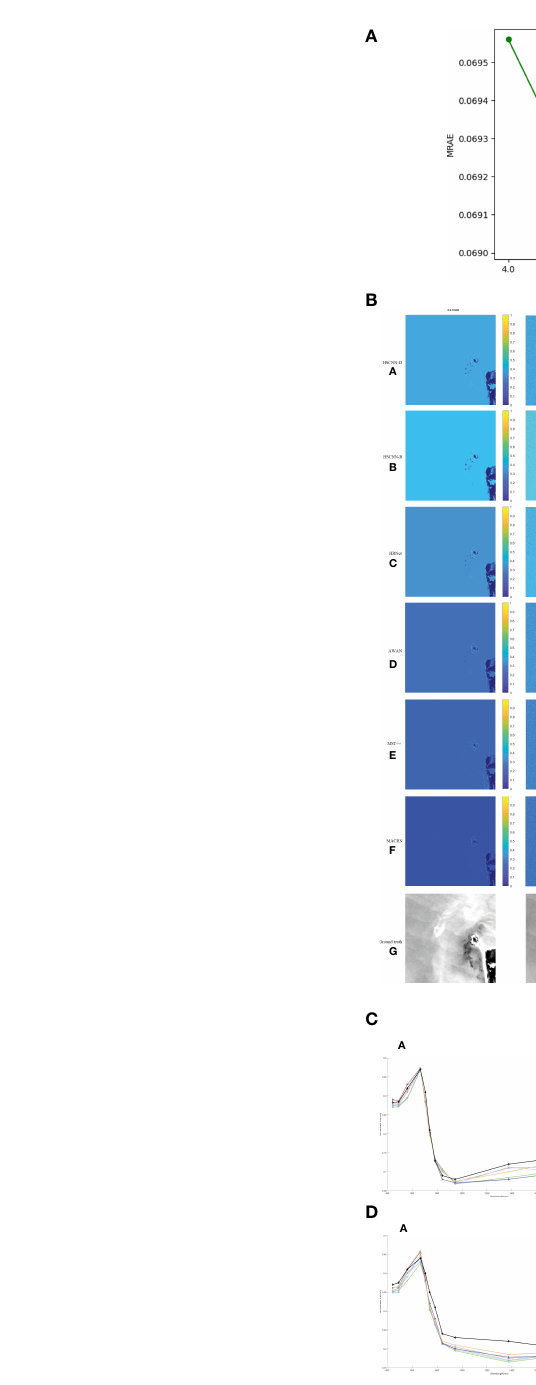
on images from the Clean dataset, compared to (f) the true hyperspectral data of the same locations. (C) Spectral response curve from the HSCNN-D, HSCNN-R, HRNet, AWAN, MACRN models run on Clean data and true observed data from Sentinel-2 (gt for ground truth) for two points from